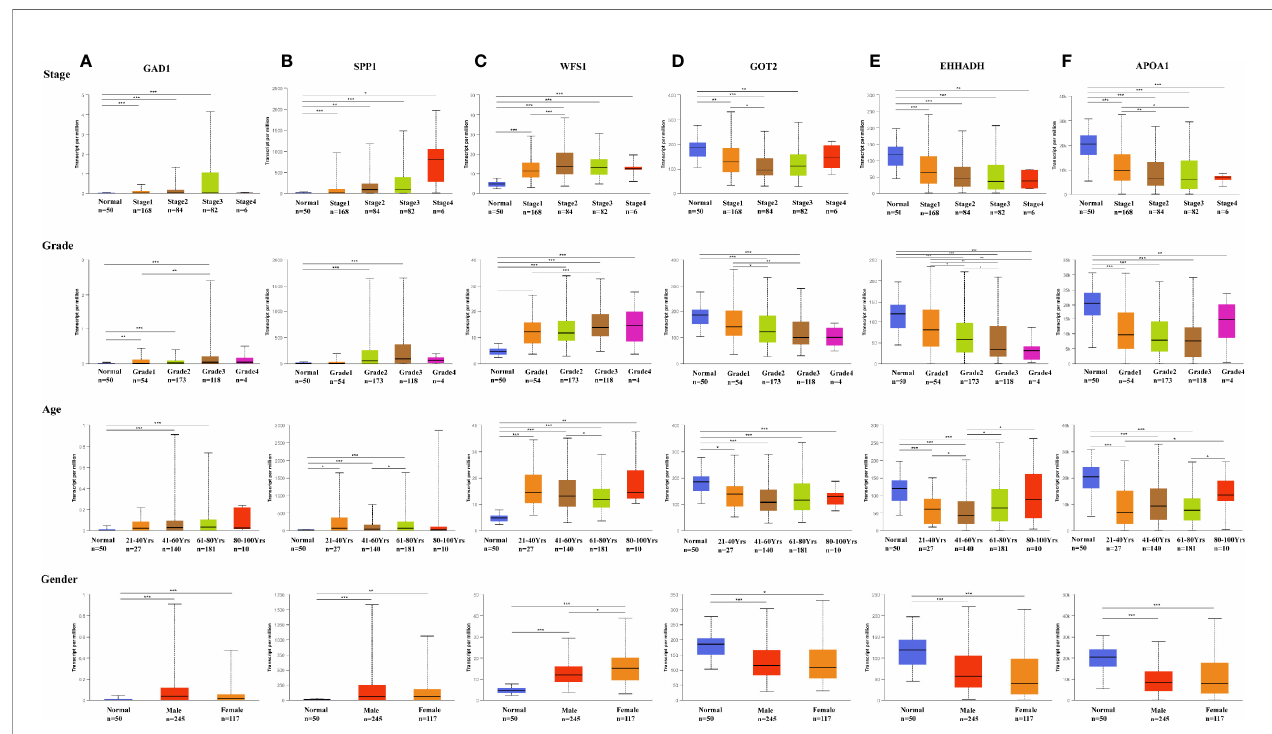
FIGURE 6 | Expression of six MRGs in HCC subgroups strati fi ed by clinical parameters in the UALCAN database. Boxplot showing the mRNA expression of six hub MRGs in HCC patients according to stage, grade, sex, and age. (A) GAD1, (B) SPP1, (C) WFS1, (D) GOT2, (E) EHHADH, (F) APOA1. *P < 0.05; **P < 0.01; ***P <